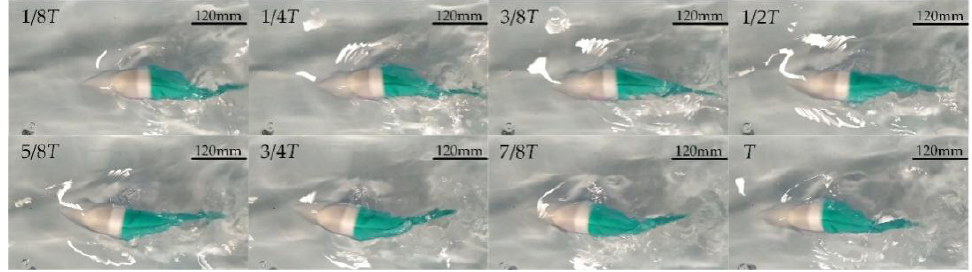
Figure 6. Sequence photos of robotic fish swimming.